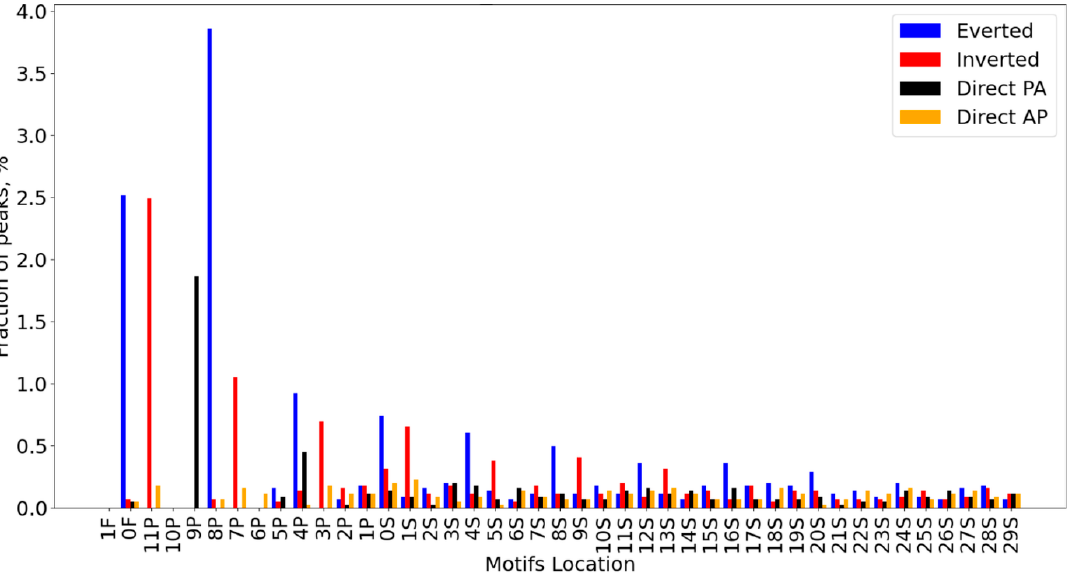
Figure 3. Distribution of structural variants of predicted CEs with various orientations, overlaps and spacers of the Anchor FoxA2 and Partner HNF1B motifs for the FoxA2 dataset [18]. Colors denote different mutual orientations. The letters in labels near axis X from left to right mean full (‘F’) or partial overlaps (‘P’), and spacer length (‘S’). The numbers preceding these letters denote the distance between nearest borders of two motifs, the length of overlap and the length of spacer, respectively. Axis Y shows the percentage of peaks containing CEs variants specific in mutual orientation and location. FoxA2 and HNF1B motifs were derived with the Homer tool [6] and the mouse Hocomoco library [14], respectively.